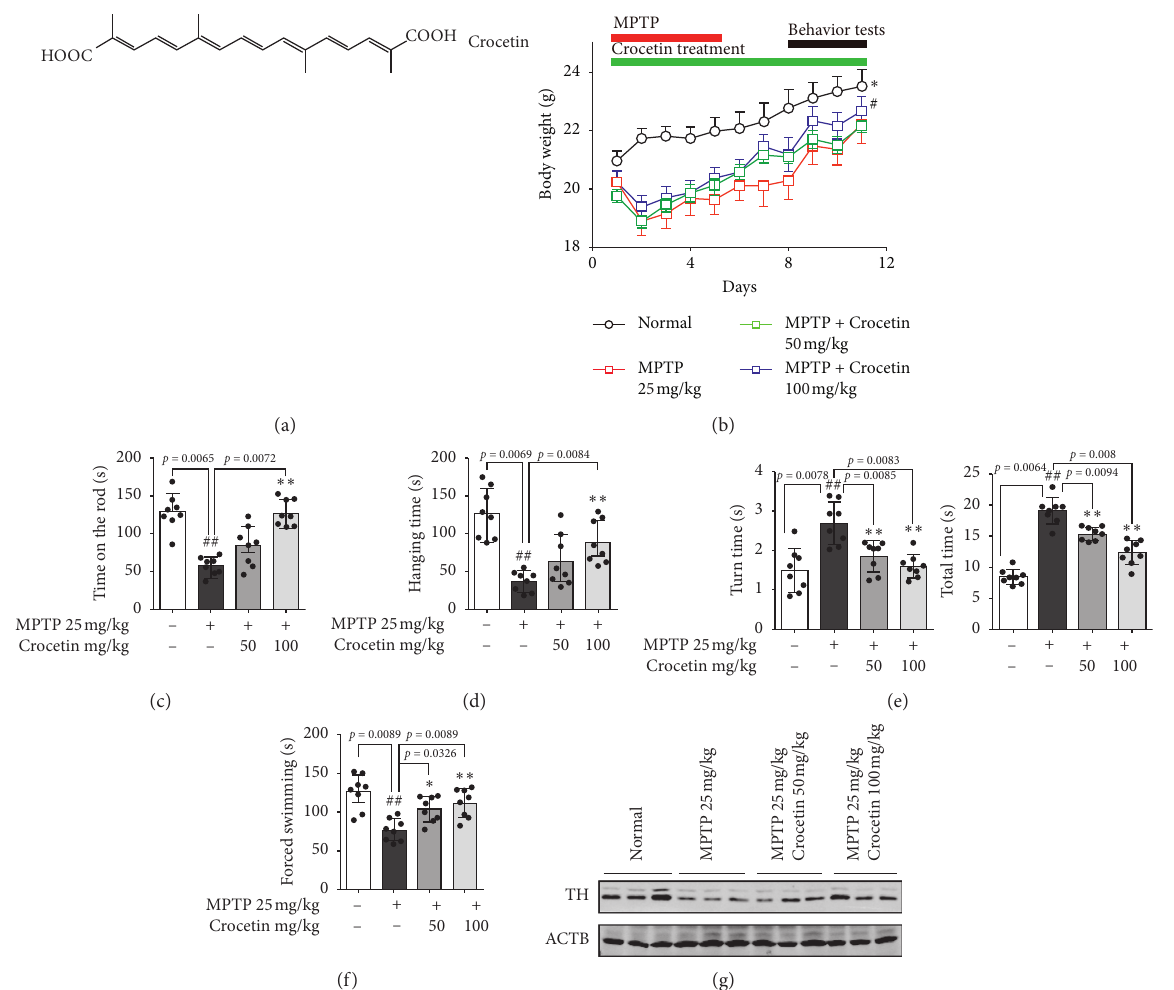
Figure 1: Crocetin ameliorates MPTP-induced motor activity impairments. C57BL/6 mice treated with MPTP (25mg/kg/d, 5 days, i.p.) were orally administered with crocetin for 11 days. (a) The structure of crocetin. (b) Weight change was monitored throughout the experiment. Outcomes of the rotarod performance test (c) and hanging performance (d) on day 8 and day 9. Bar graphs reveal the latency to fall in seconds (s). (e) Time to turn and total time in pole test was recorded on day 5 after the cease of MPTP treatment. (f) The total time of forced swimming was recorded. (g) Western blot determination of tyrosine hydroxylase (TH) expression levels in the striatum of each group. Data are expressed as the mean ± standard deviation, and statistical analysis was performed using a one-way analysis of variance followed by Tukey’s post hoc test. # P < 0 . 05, ## P < 0 . 01 versus normal; ∗ P < 0 . 05, ∗∗ P < 0 . 01 versus MPTP, n � 8 mice in each